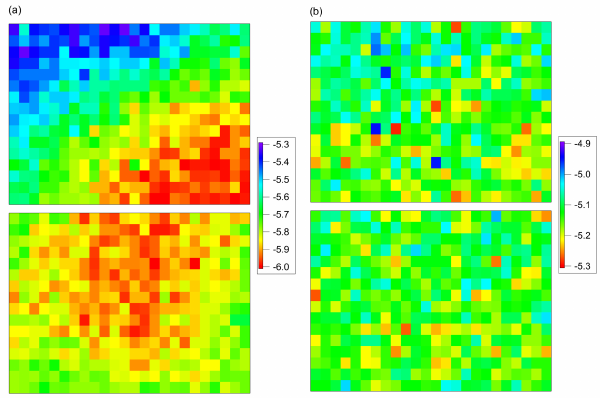
Figure 4. Measurement of temperature gradient of 384-well sample holder block using Mortierella alpina 13A as calibration substance. A correction matrix was calculated to compensate for temperature gradient and offset. (a) Data before correction. (b) Data after cor- rection.